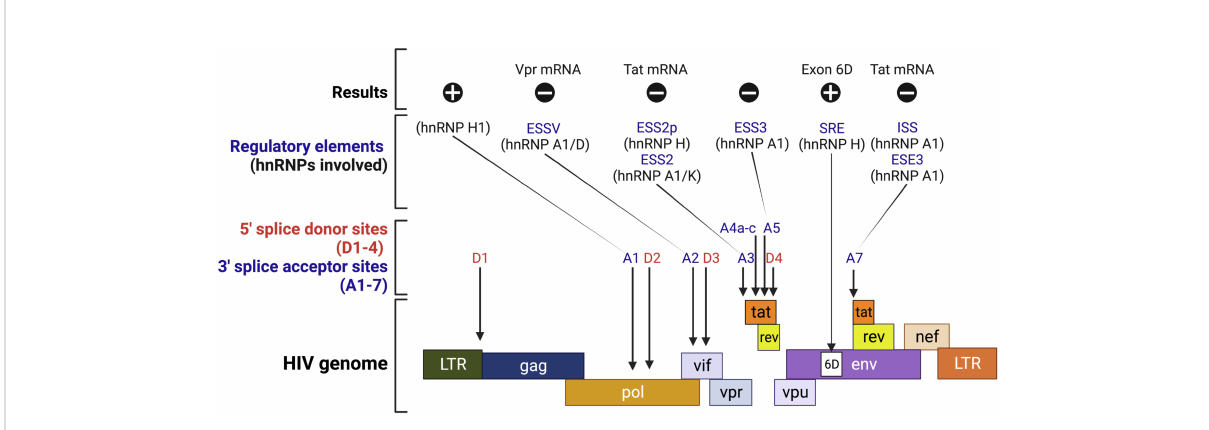
FIGURE 5 Schematic representation of the HIV genome. This fi gure shows splice sites and the interfering and interacting positions of hnRNP proteins in the HIV splicing sites. , positive regulation; ϴ , negative regulation; ESS, exonic splicing silencer; ESE, exonic splicing enhancer; ISS, intronic splicing silencer; SRE, splicing regulatory element. The image was created with